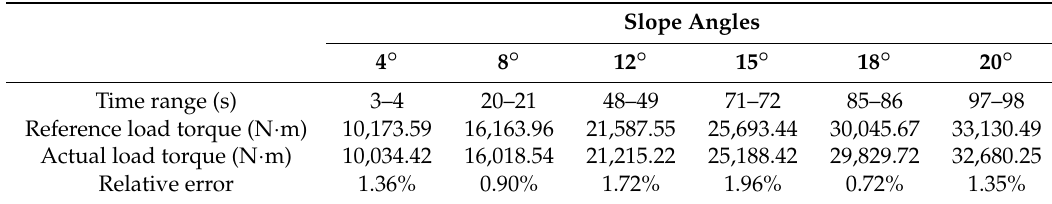
Table 3. Load emulation performance under the driving condition of straight line with different slope angles.